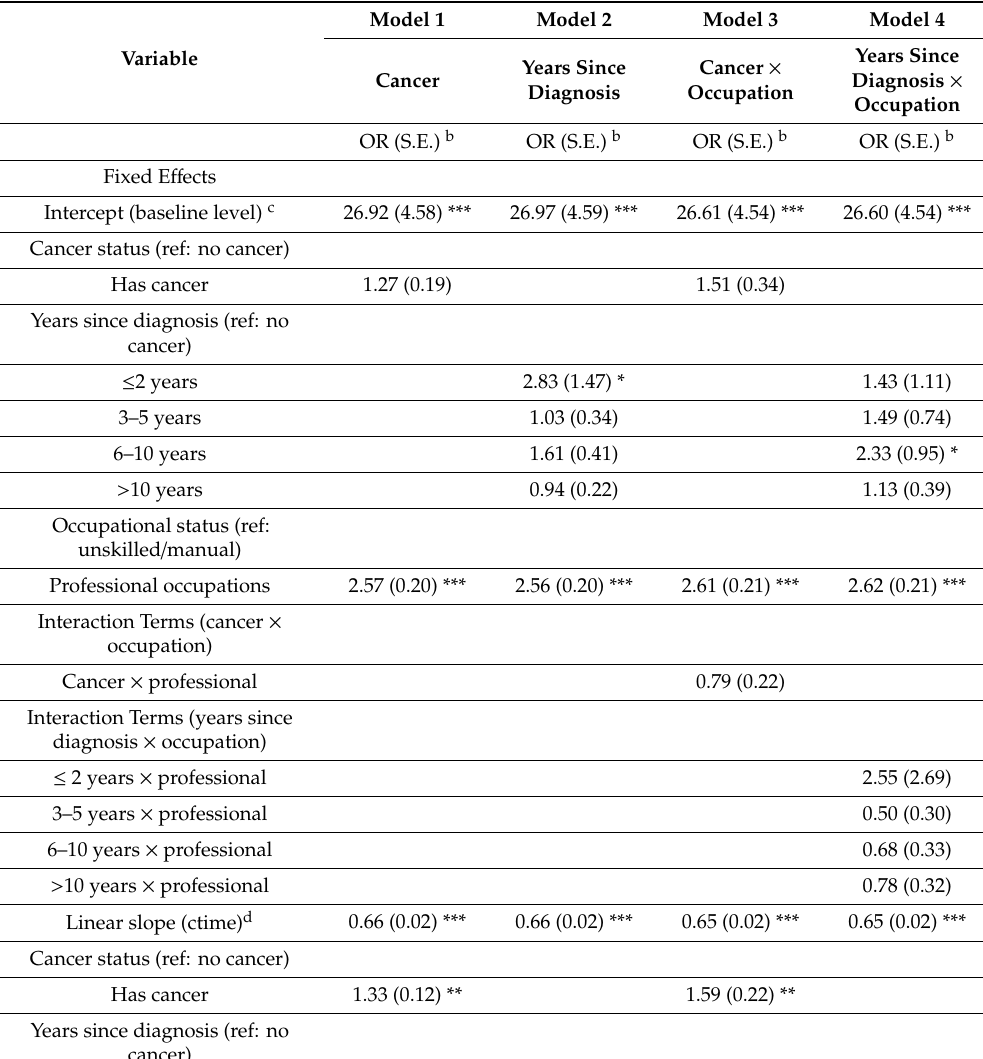
Table 2. Cancer and Employment Status among Women.